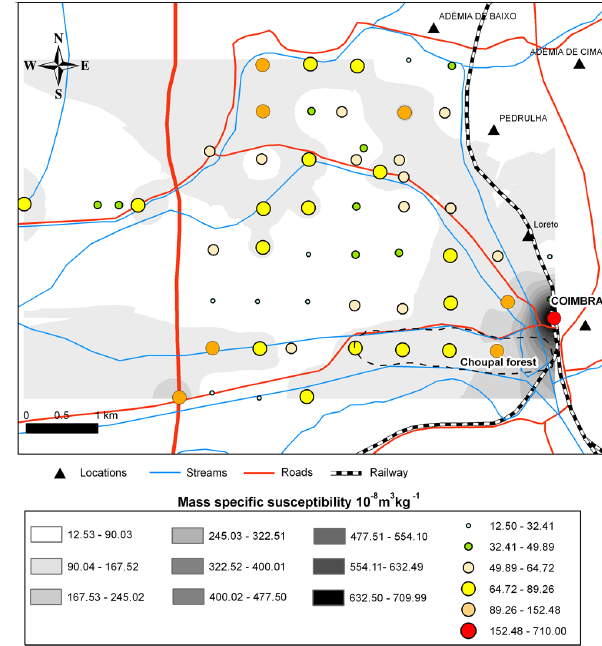
Fig. 8. Spatial variation of χ